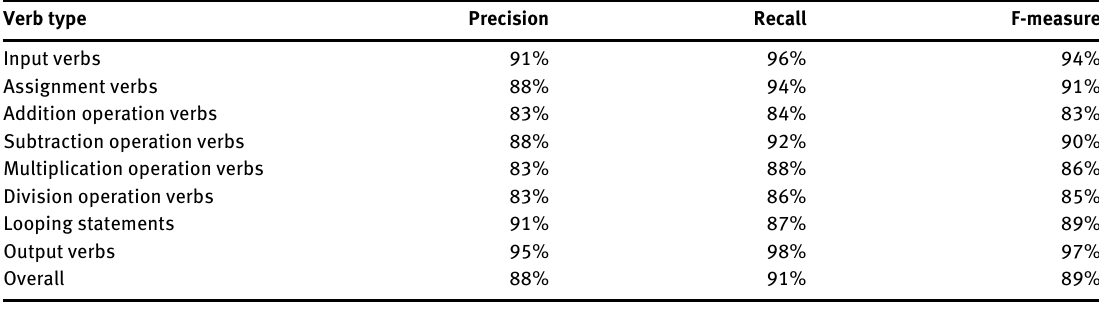
Table 7: Binomial Classification Accuracy of CodeComposer.